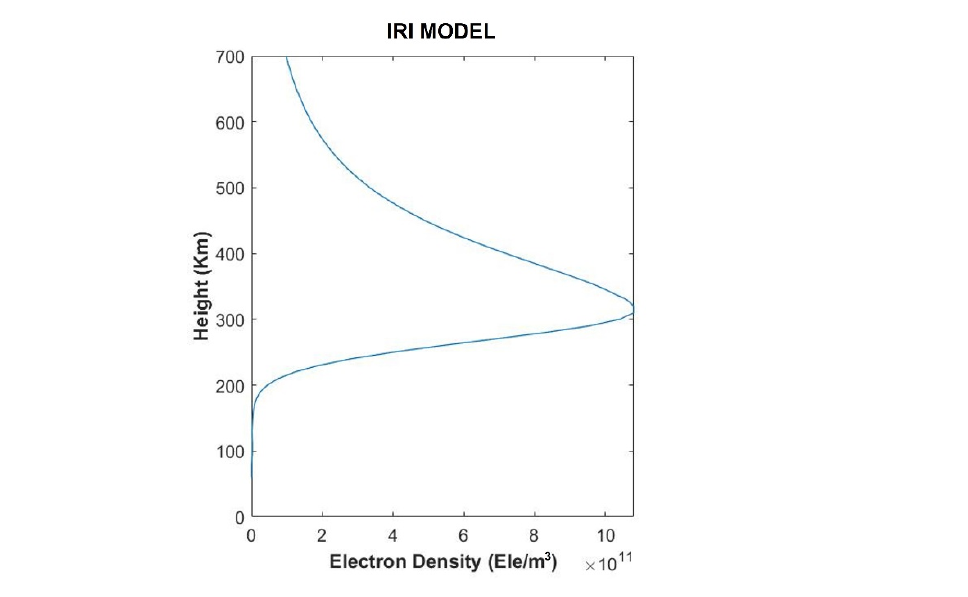
Figure 7. The vertical electron density profiles reconstructed over the epicenter at CID occurred (13.06 UT) from the IRI model (https://irimodel.org/, accessed on 23 June 2022).